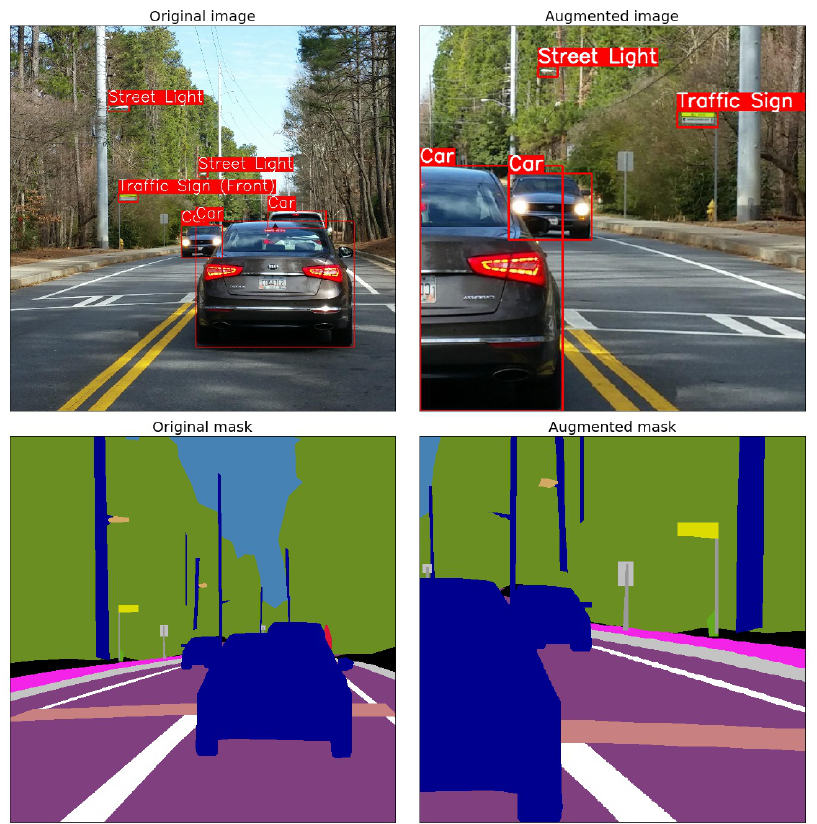
Figure 4. An example of applying a combination of transformations available in Albumentations to the original image, bounding boxes, and ground truth masks for instance